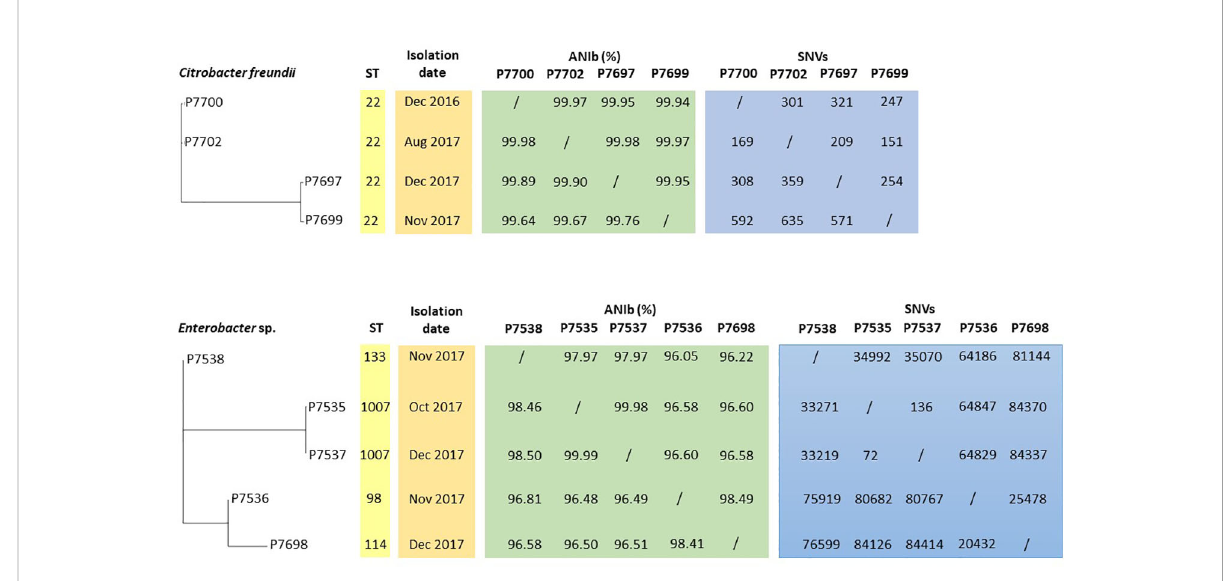
FIGURE 3 Phylogenetic tree based on the pangenome of C. freundii and Enterobacter sp. strains associated with ST, isolation date, ANIb and SNV